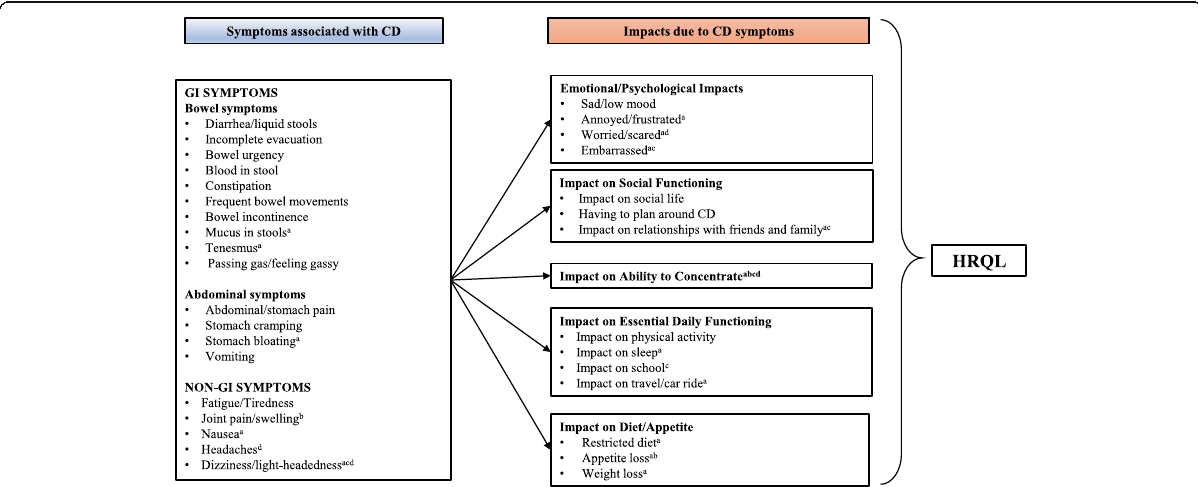
Fig. 1 Patient-Centered Conceptual Model of Pediatric CD. Abbreviations: CD = Crohn ’ s disease; GI = gastrointestinal; HRQL = health-related quality of life. a Not discussed by children 5 – 7 years old; b not discussed by children 8 – 11 years old; c not discussed by parents of children 2 – 4 years old;